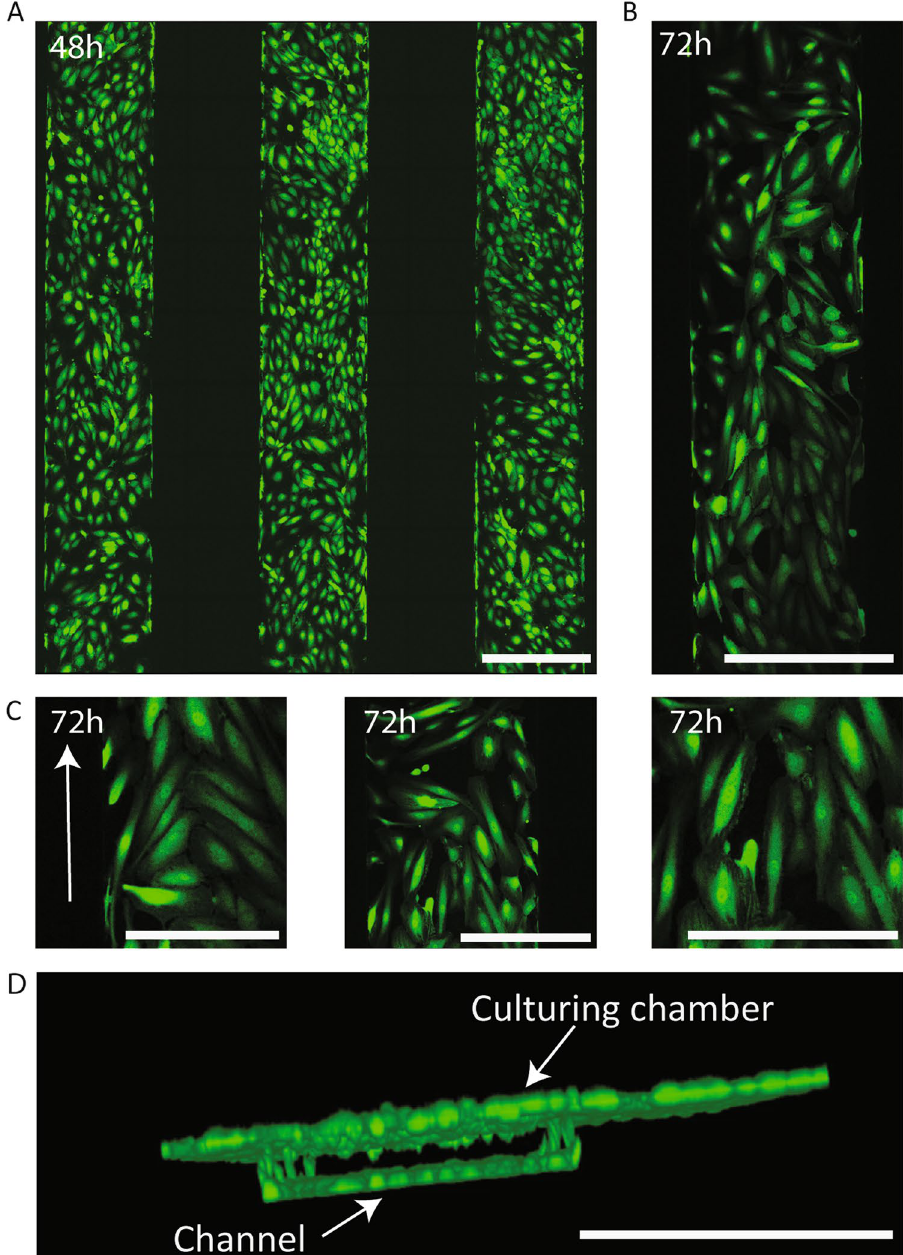
Figure 3. GFP + HUVECs seeded on microfluidic chip channels form synthetic 3D vessels. ( A ) fluorescence image of the chip’s three microfluidic channels after 48 h of static culture, showing GFP + HUVECs forming a monolayer inside these channels. ( B ) Fluorescence image of a chip channel after 48 h of static culture + 24 h of flow, showing HUVECs remained in the channels after exercising fluidic stress and adopted a directionality concurrent with the flow direction. ( C ) Detail images of the chip channels after 48 h of static culture + 24 h of flow, in which the directionality acquired by the HUVECs can be observed (indicated with arrow). ( D ) 3D render of confocal stack of a chip channel lined with GFP + HUVECs showing establishment of a 3D synthetic vessel presenting cells in all planes. Scale bars = 500 µm ( A , B , D ) and 250 µm ( C